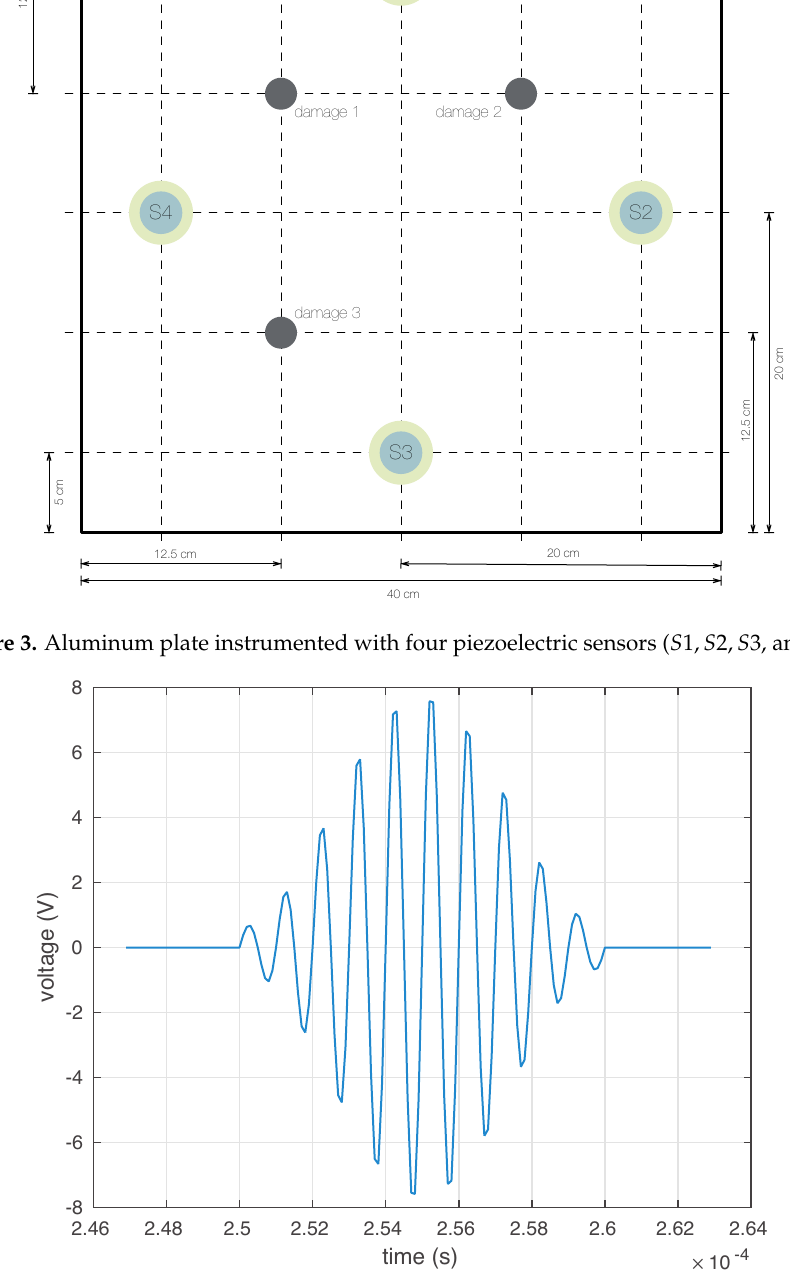
Figure 4. In actuator mode, this burst signal is applied to the piezoelectric transducers (PZTs) to produce a mechanical